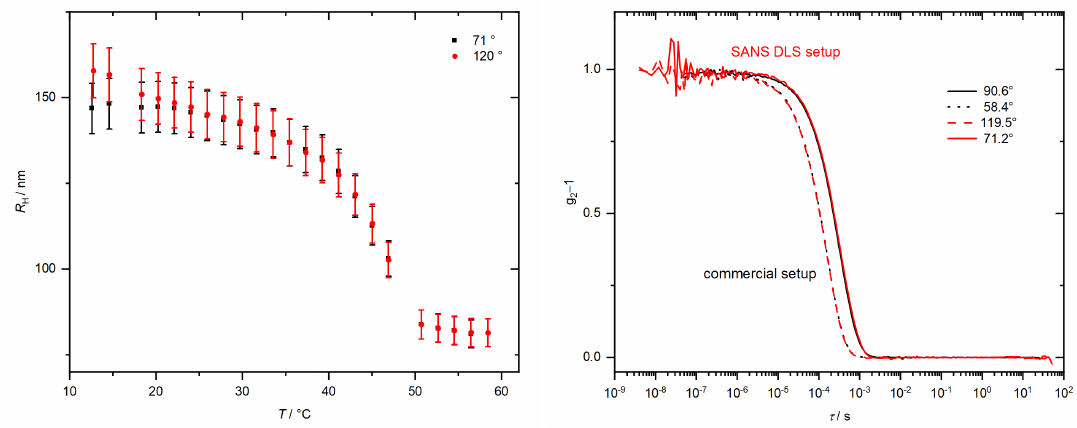
Figure 5. ( left ): Swelling behavior of a NIPMAM microgel measured with the SANS/DLS setup at both scattering angles. ( right ): comparison of autocorrelation functions of the NIPMAM microgel at 56°C for both angles (red) compared to ACFs measured with a commercial ALV setup (black curves, measured with a different laser wavelength and therefore at different angles to achieve the same q value) at the same q -values of 0.23nm − 1 and 0.15nm − 1